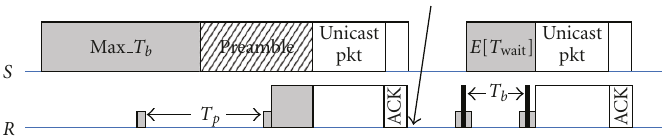
Figure 6: The adaptive DW-LPL scheme with AIMD + MW.